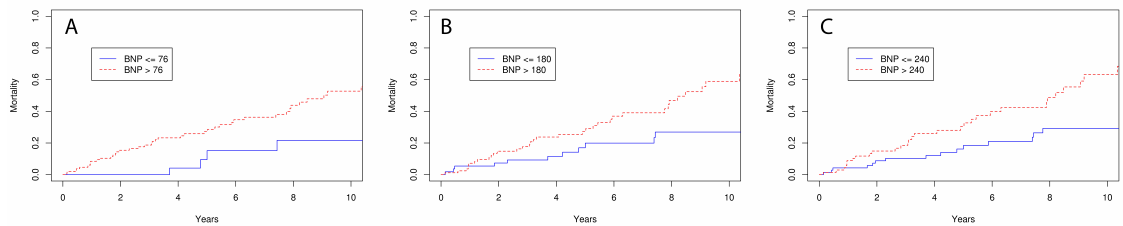
Figure 1. Kaplan–Meier mortality curves for ( A ) BNP cutoff of 76 pg/mL, ( B ) BNP cutoff of 180 pg/mL, and ( C ) BNP cutoff of 240